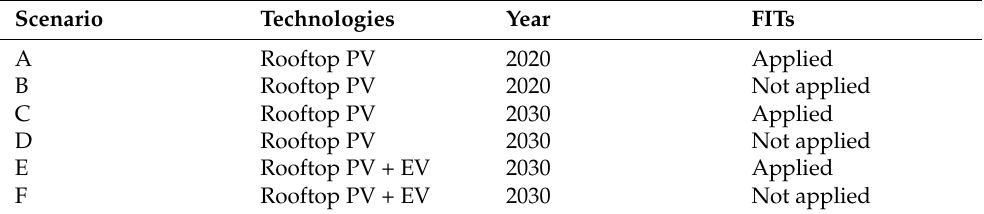
Table 4. Different scenarios considered for the analyses with FITs in Bangkok City in 2020 and 2030.